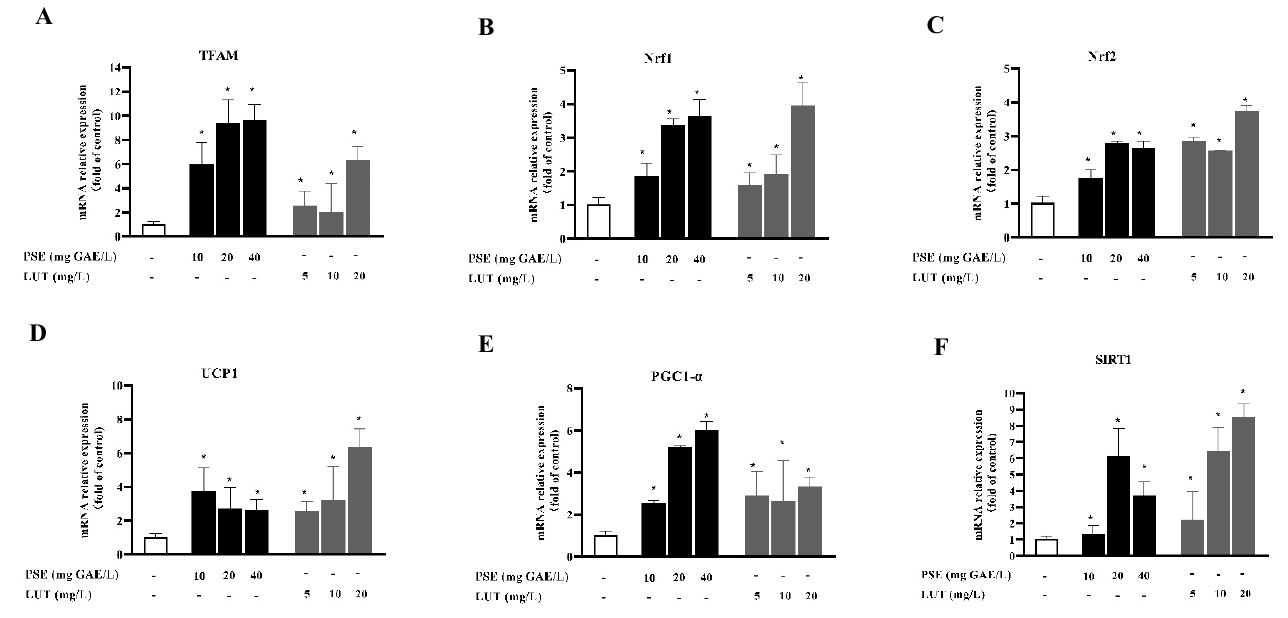
Figure 9. PSE and LUT modulated the expression of the core browning gene in the 3T3-L1 adipocytes. The relative mRNA expressions of ( A ) TFAM, ( B ) Nrf1, ( C ) Nrf2, ( D ) UCP1, ( E ) PGC1- α , and ( F ) SIRT1. The data are presented as the mean ± SD from three independent experiments. * Significant differences are indicated by p < 0.05.